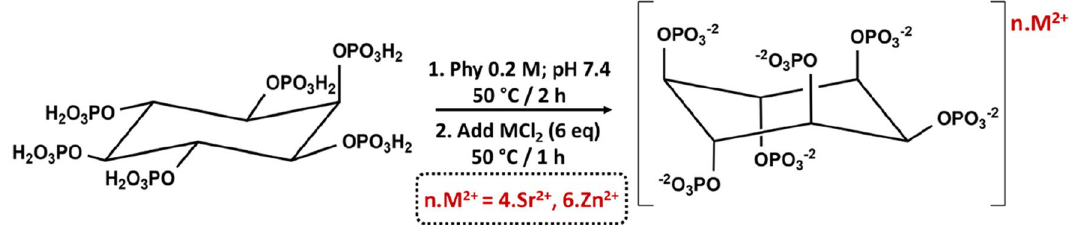
Figure 1. Scheme of the chemical procedure followed for the synthesis of the strontium (SrPhy) and zinc (ZnPhy) complexes of phytic acid.